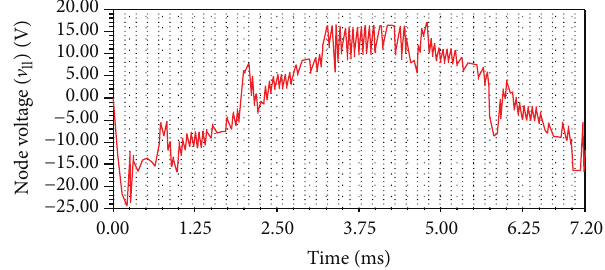
Figure 28: The line-to-line voltage waveform in hysteresis control mode (with filter).